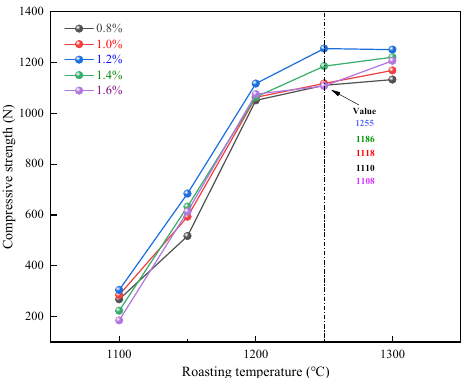
Figure 7. Effect of roasting temperature on the compressive strength of